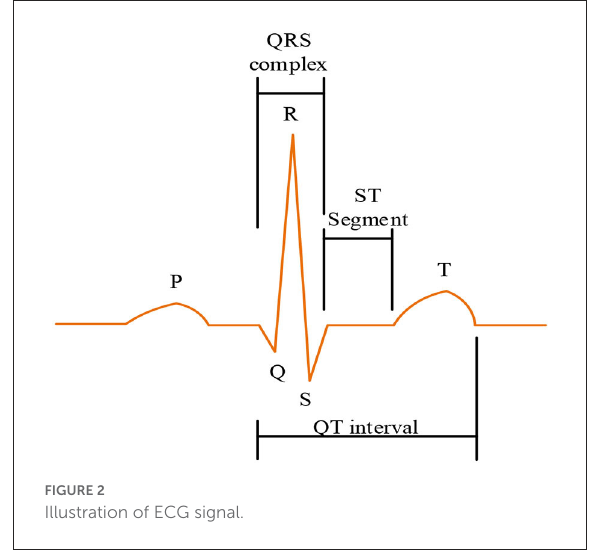
FIGURE2 Illustration of ECG